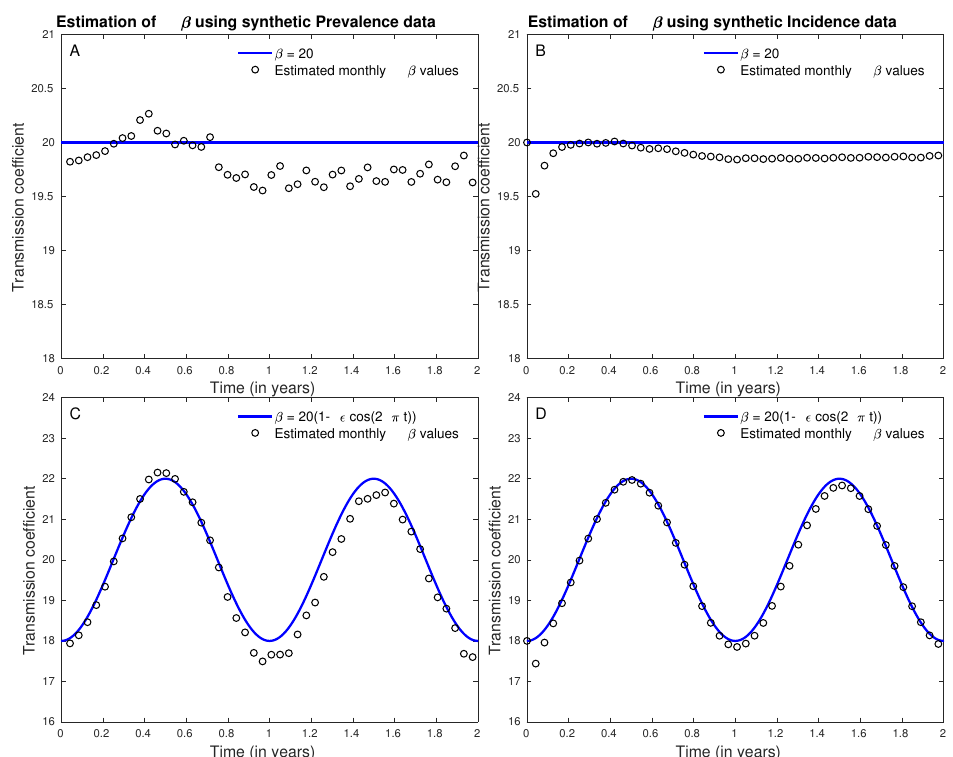
Figure 10. Monthly estimates of transmission coefficients and their true values used to generate syn- thetic prevalence data ( A , C ) and synthetic incidence data ( B , D ) for constant transmission coefficient ( A , B ) and periodic transmission coefficient ( C , D